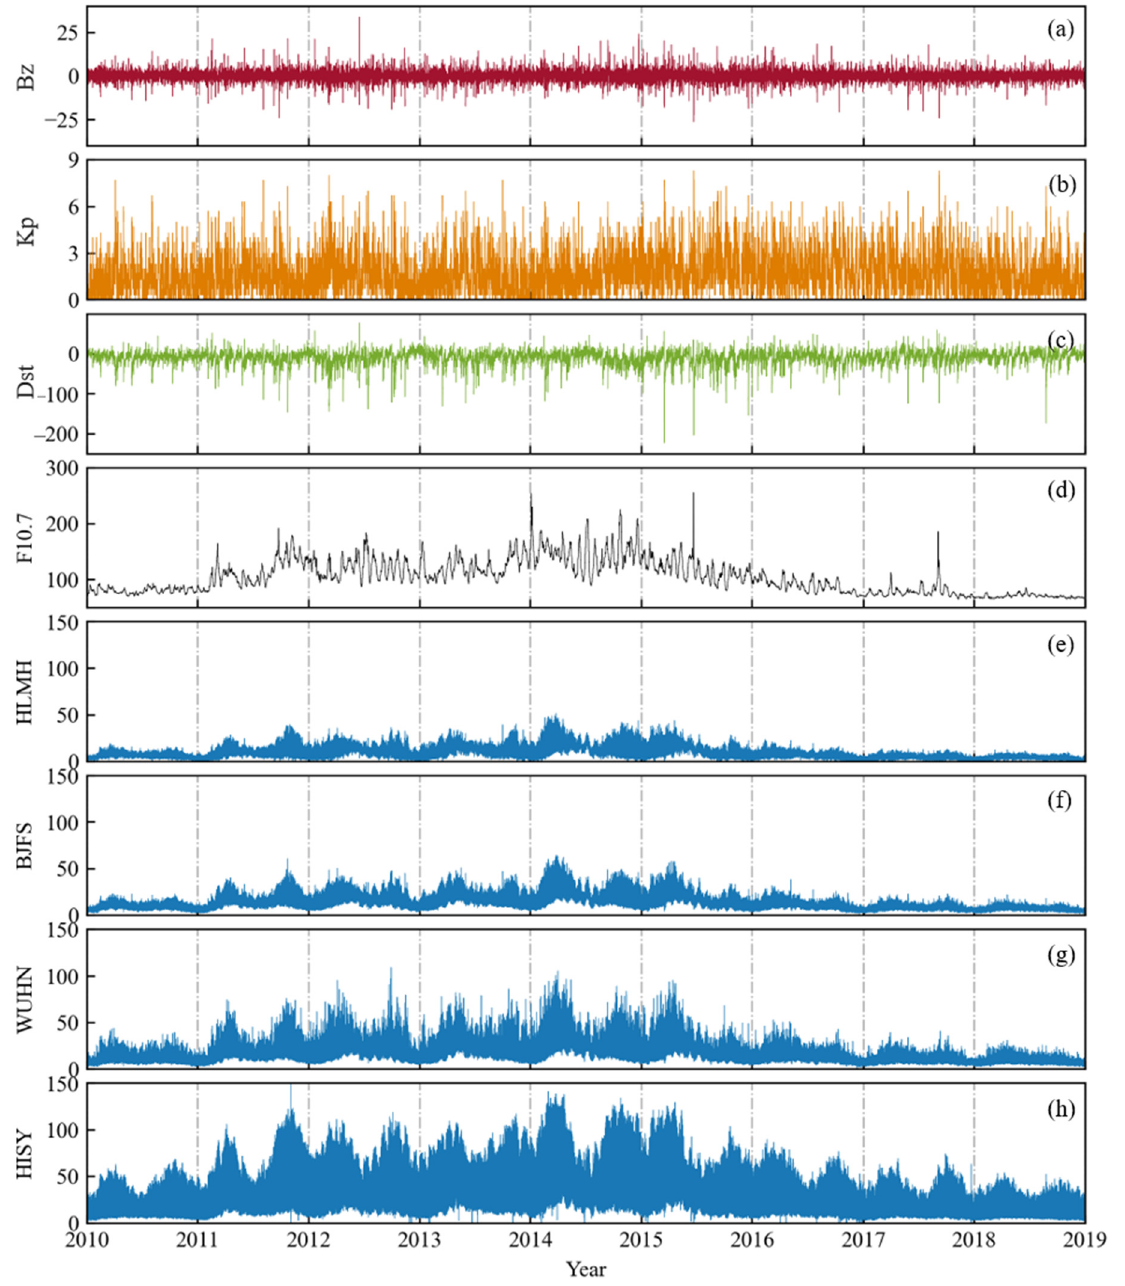
Figure 4. Variations of ( a ) Bz, ( b ) Kp, ( c ) Dst, ( d ) F10.7 indices and TEC values at ( e ) HLMH, ( f ) BJFS, ( g ) WUSH, and ( h ) HISY stations from 2010 to